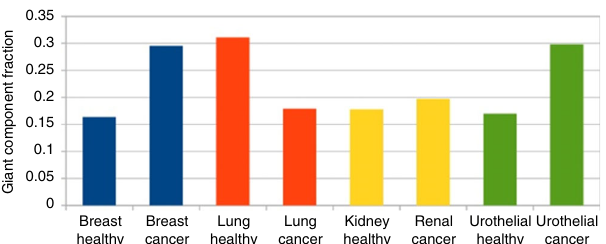
Fig. 4 Fraction of giant component in healthy and cancer tissues. In these networks, nodes represent reactions and two reactions are connected if the absolute fl ux correlation between them is higher than 0.5, as described in Methods. The giant component is the largest connected component in each network; the fraction was calculated by dividing the number of nodes in the giant component through the total number of nodes in each network